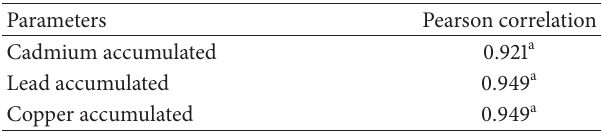
Table 3: Pearson correlation coefficients between catalase activity and metals